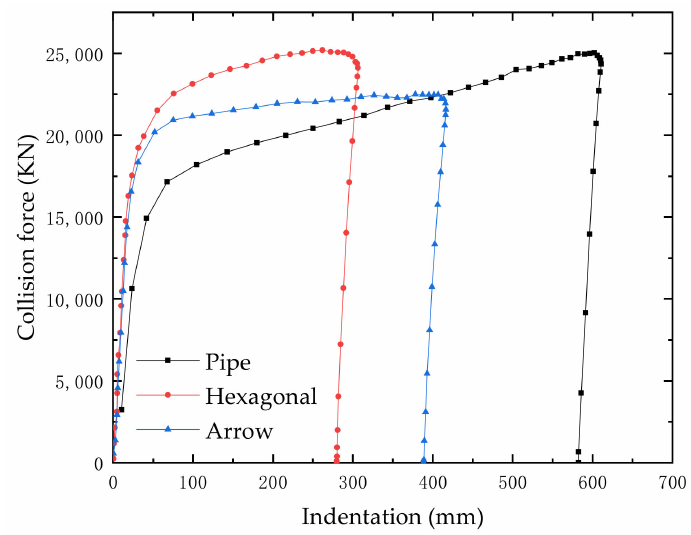
Figure 28. Collision force–indentation curves of different structures at 2 m/s during side